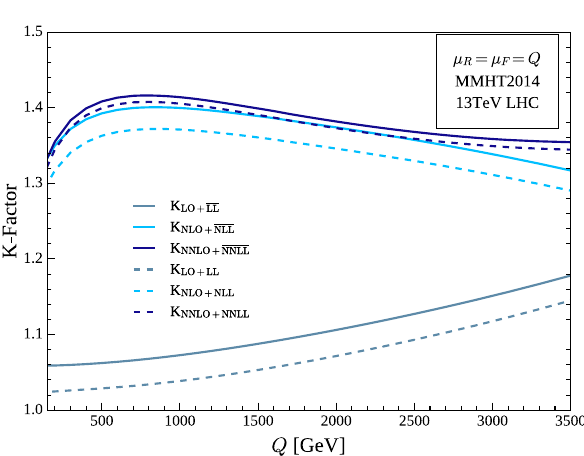
Fig. 9 AcomparisonoftheK-factorsofbothSVandSV+NSVresum- mation for 13 TeV